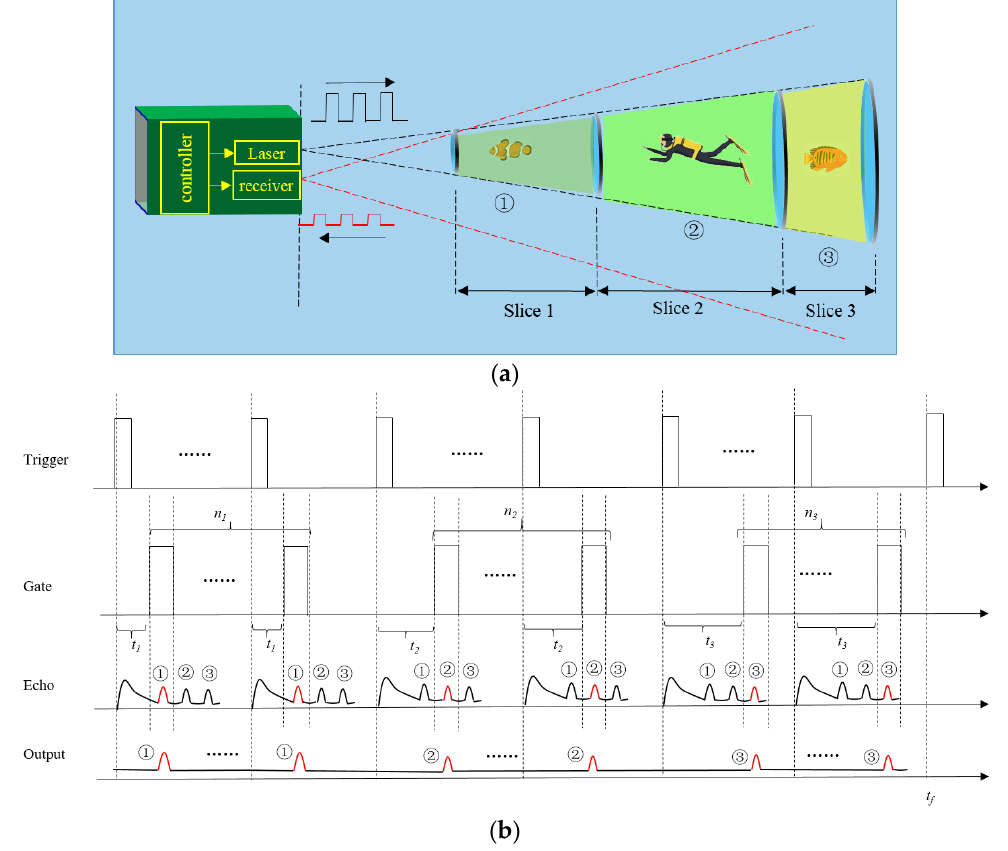
Figure 1. Description and time sequence of the MSI method with three slices: ( a ) three targets are in three adjacent slices respectively; ( b ) time sequence of the MSI method. The same delay time belongs to the same slice, the gate width is small, and only one target echo can be passed.